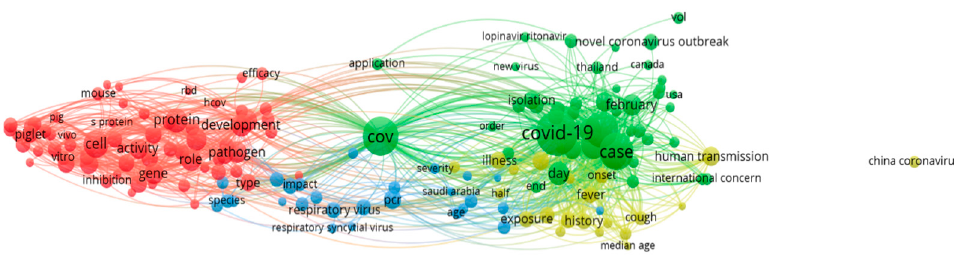
Figure 13. 2020 term co-occurrence map.